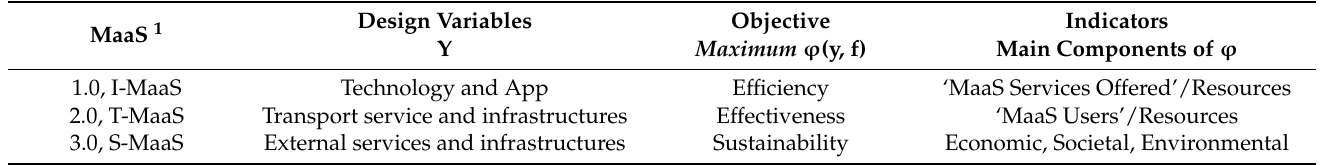
Table 1. Main sets of components of objective function and decision variable in MaaS. Design Variables Objective Indicators MaaS 1 Maximum ϕ (y, f) Y Main Components of ϕ Technology and App Efficiency ‘MaaS Services Offered’/Resources Transport service and infrastructures Effectiveness ‘MaaS Users’/Resources Sustainability Economic, Societal,